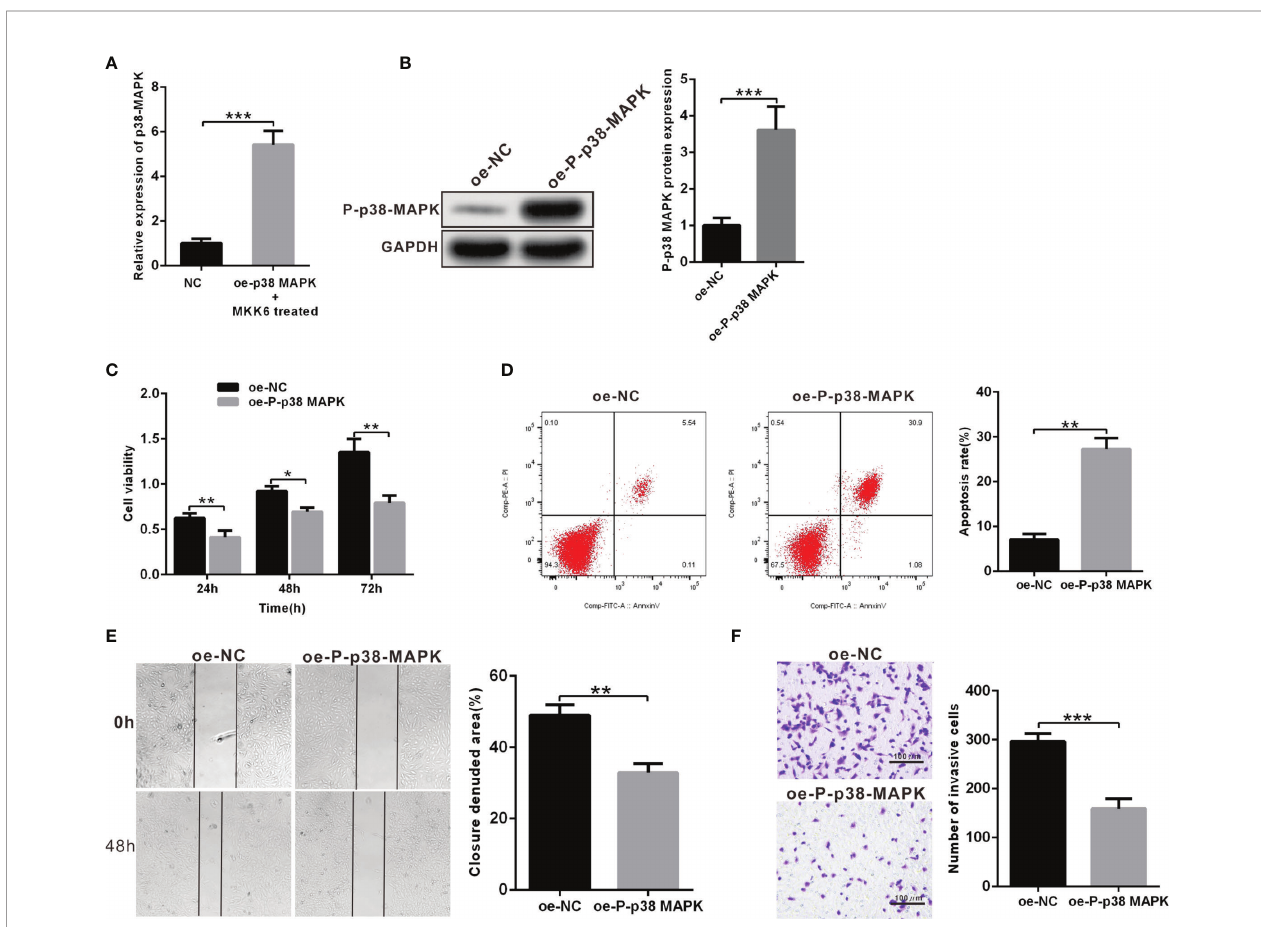
FIGURE 2 | Overexpression of P-p38 MAPK contributes to inhibited tumor cell proliferation, metastasis and invasion and accelerated apoptosis. (A) p38 MAPK expression in oe-p38 MAPK or NC-transfected Y79 cells was measured using RT-qPCR. (B) P-p38 MAPK expression in Y79 cells was measured using western blot analysis. (C) Cell viability was determined using CCK-8. (D) Cell apoptosis was detected using fl ow cytometry. (E) Cell migration was measured by scratch test. (F) Cell invasion was tested using Transwell assay. * p < 0.05 vs. oe-NC-transfected Y79 cells. ** p < 0.01, *** p < 0.001. The measurement data was expressed by mean ± standard deviation. The two groups of data conforming to the normal distribution were compared using unpaired t